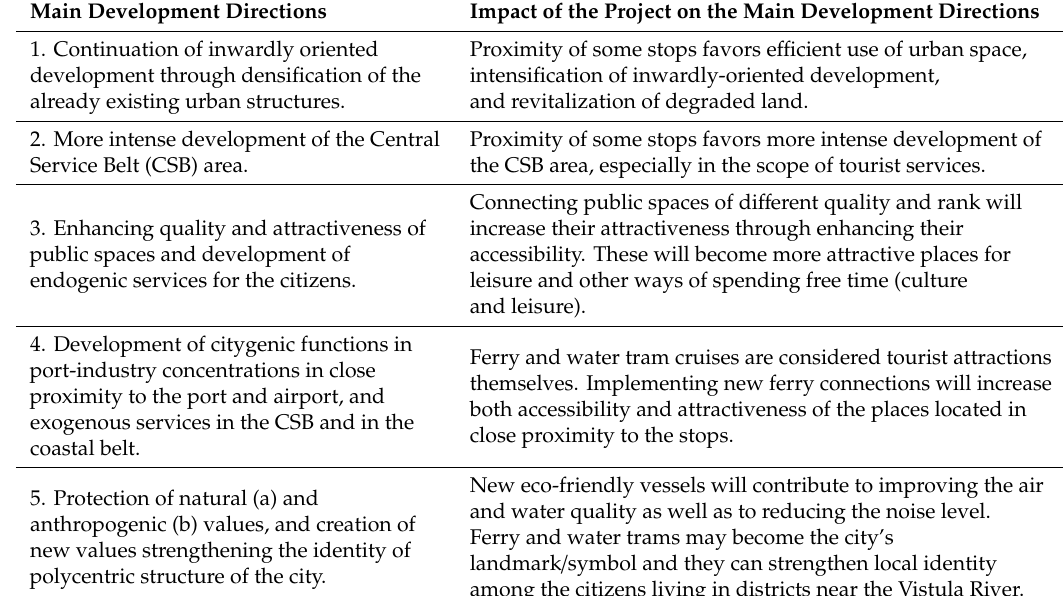
Table 8. Possible results of introducing all-electric ferries and hybrid water trams into the transport system in Gda´nsk, and their impact on the main development directions of the